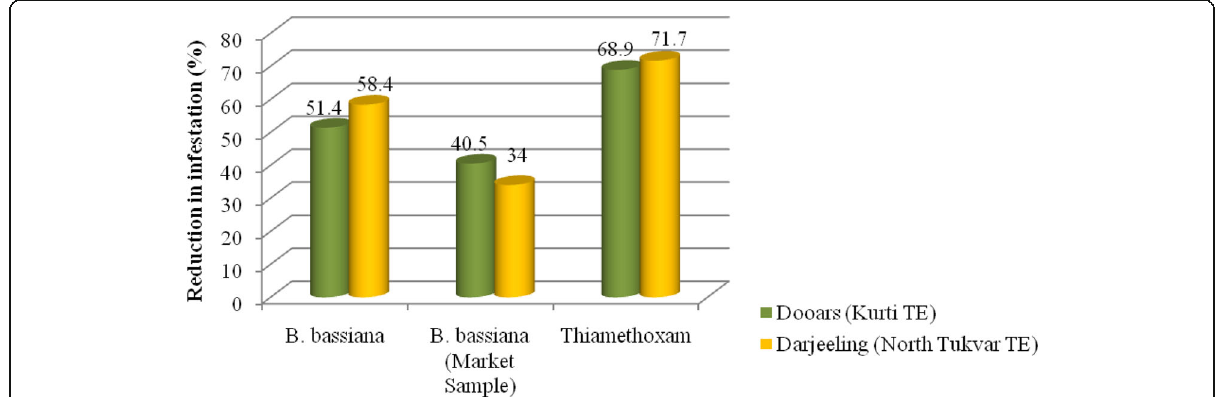
Fig. 5 In vivo bioefficacy of Beauveria bassiana against Helopeltis theivora